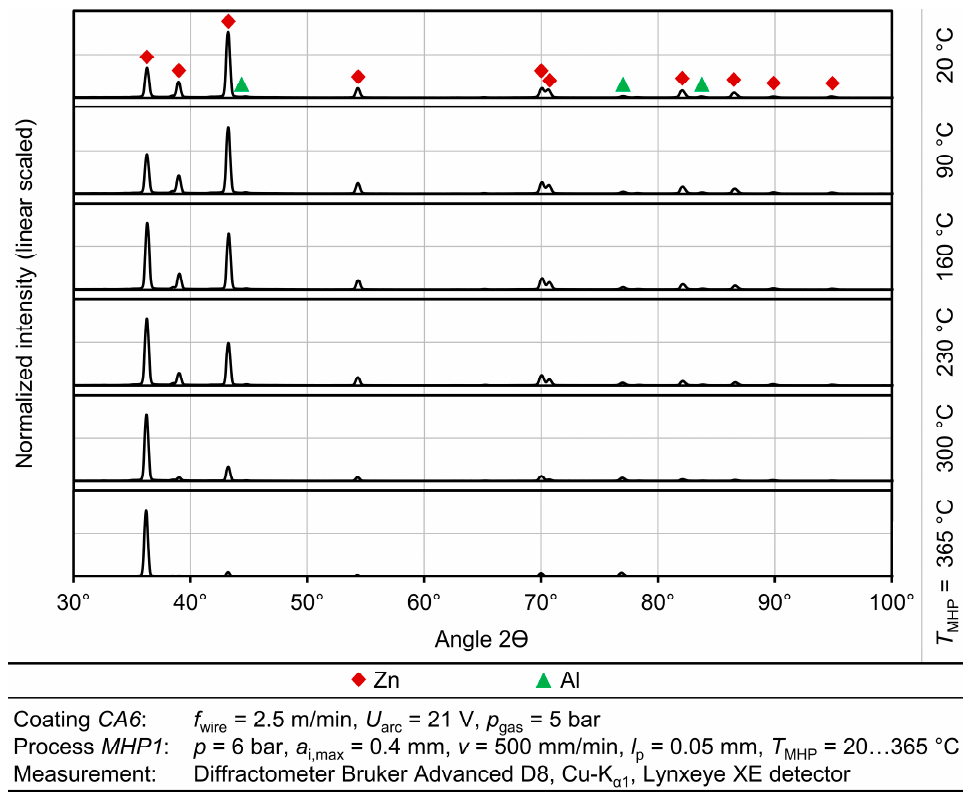
Figure 10. XRD patterns of ZnAl4 coatings after MHP treatment at temperatures between T MHP = 20 °C and T MHP = 365 °C.